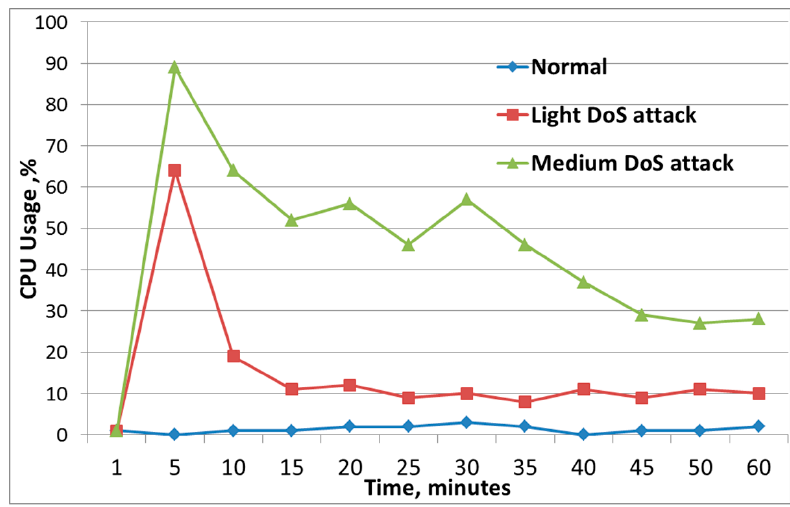
Figure 8. Changes in in central processing unit (CPU) load during denial of service attack.